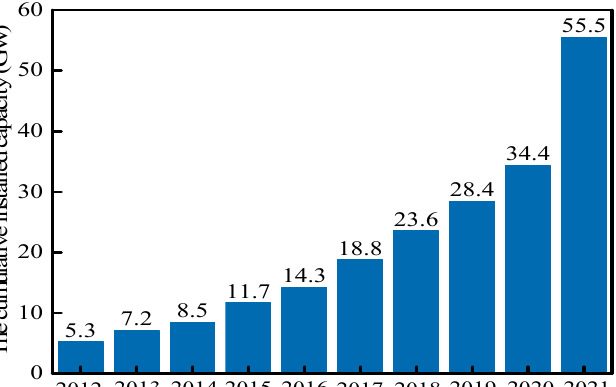
Figure 1. The cumulative installed capacity of offshore wind power in the world in the past ten years.